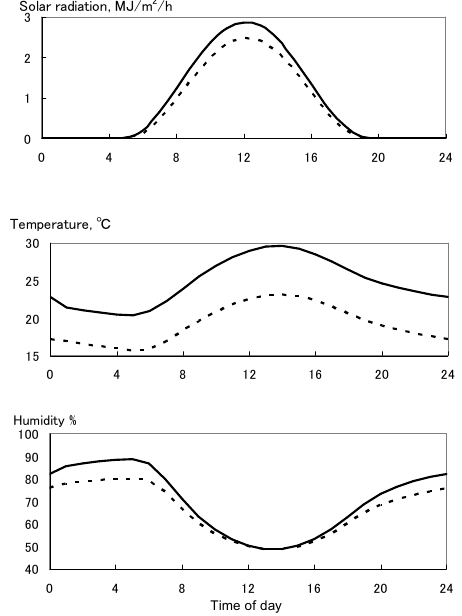
Fig. 7. Mean meteorological conditions for the 95–100th (solid lines) and the 75–80th (dashed lines) percentile rank intervals of O 3max in the TMA. Values are for weekdays, but those on Sundays are similar. Daytime water vapor concentrations (volume mixing ratios) are nearly constant (2.1% for the 95–100th, and 1.4% for the 75–80th percentile rank